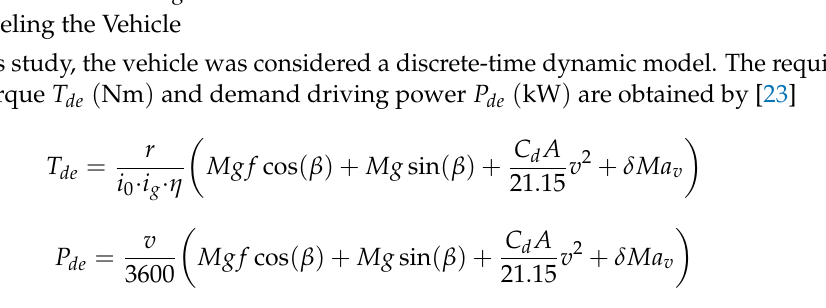
Figure 6. Energy consumption proportions of the devices onboard.